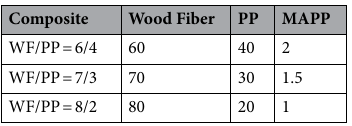
Table 1. Mass ratios of the WF/PP composites.